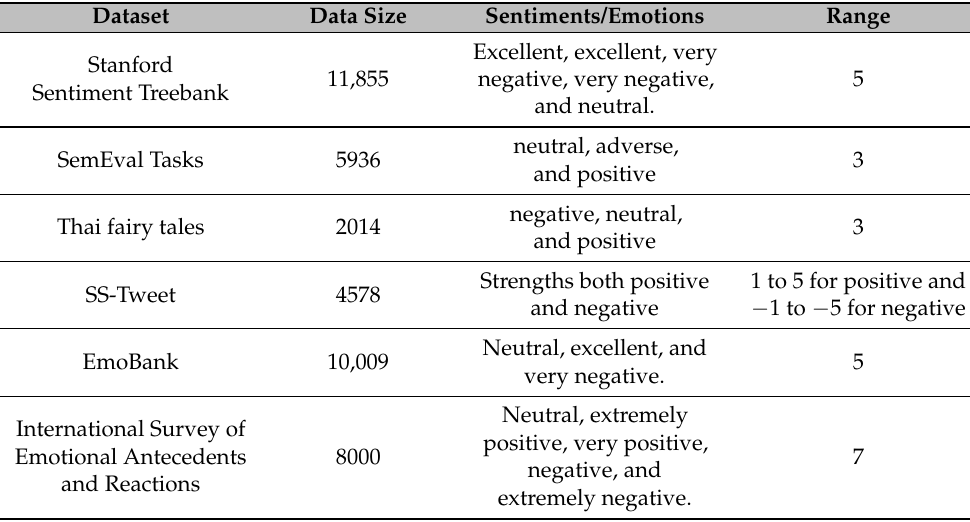
Figure 3. Emotion detection datasets with their corresponding data sizes. (“International Survey of Emotional ...” means “International Survey of Emotional Antecedents”). Table 1. Sentiment analysis and emotion detection datasets.